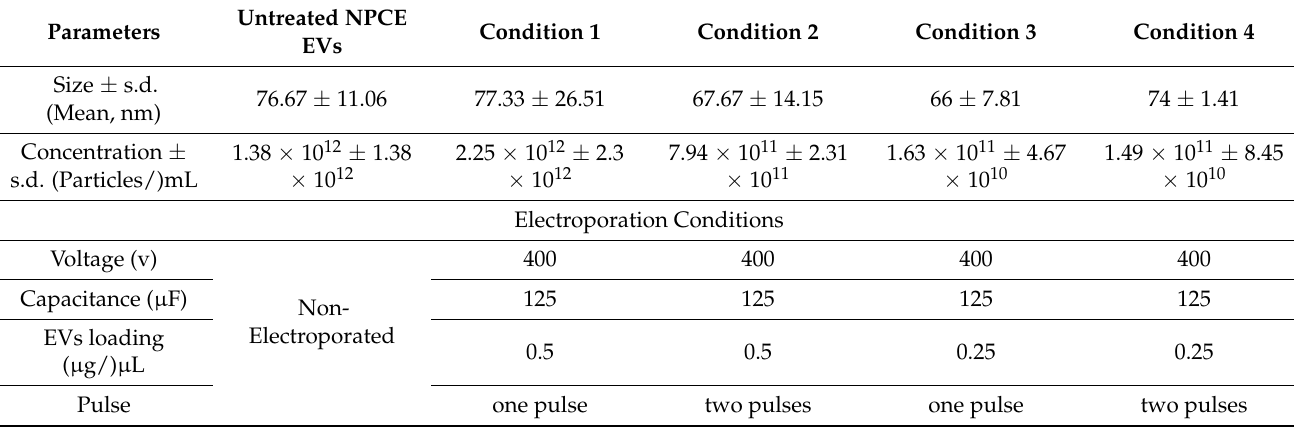
Table 1. Summary of thd electroporation’s effects on NPCE EVs size and concentration by TRPS technology.